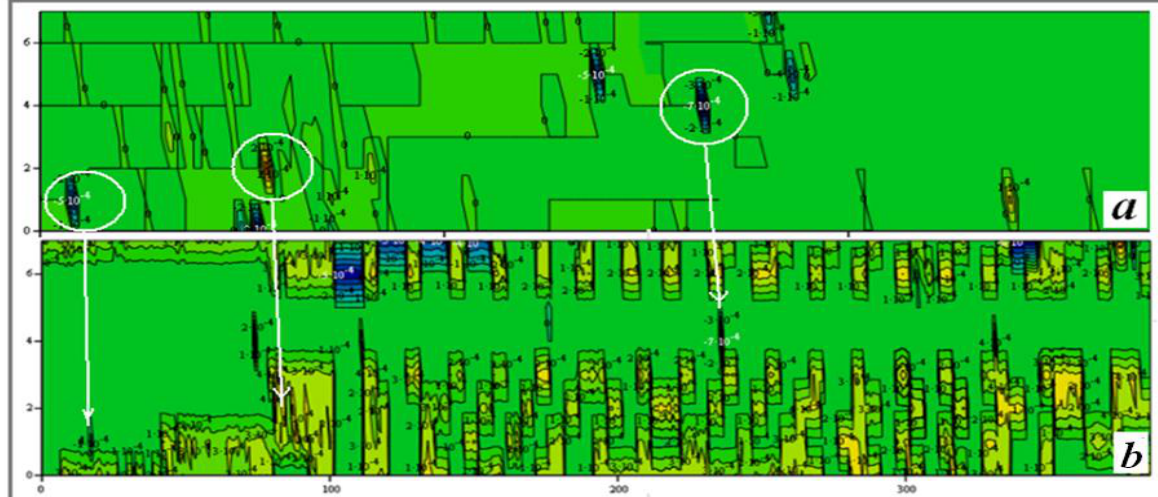
Figure 6. Potentiograms of manual scanning by (a) EDSS-1RD roller sensor, and (b) point-by-point pen sensor for SLS =